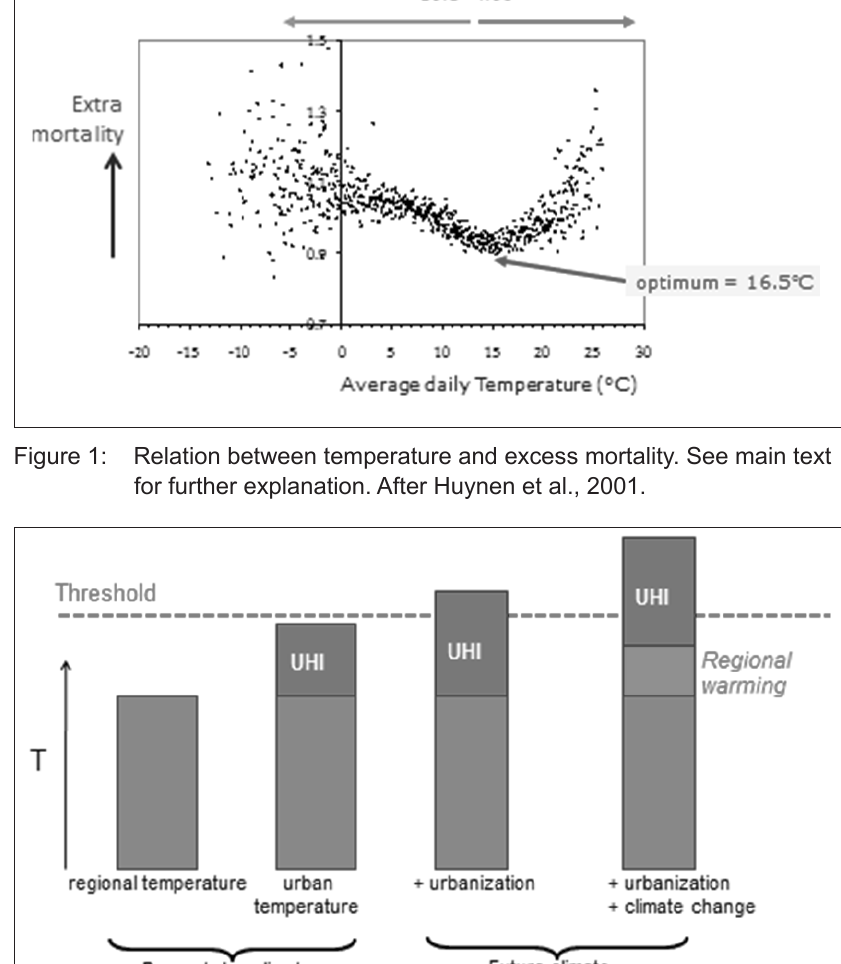
Figure 2: Influence of climate change and urbanisation on heat stress. Urbanisation affects the urban heat island (UHI). See main text for further explanation. Figure design: Bert van Hove, Wageningen